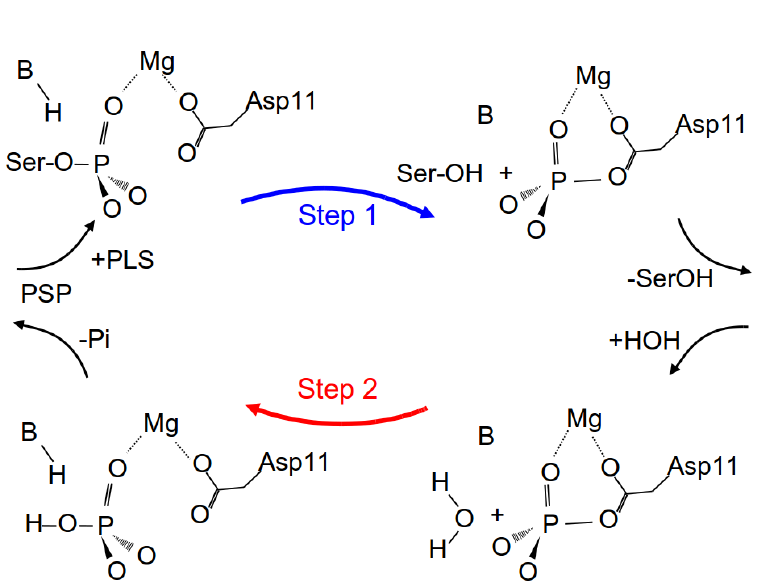
Figure 2. Reaction scheme of the two steps in the proposed mechanism of the phosphate transfer catalysed by phosphoserine phosphatase PSP. Phospho- L -serine (PLS) is bound by the